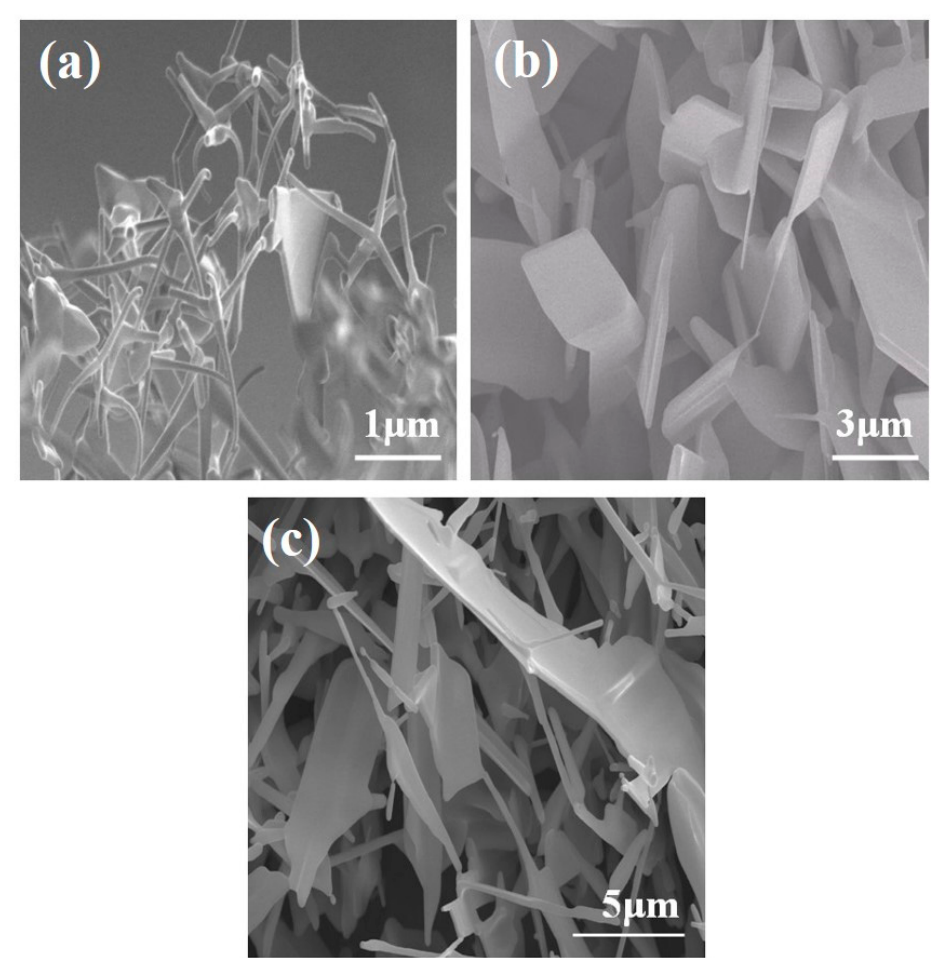
Figure 2. Field-emission scanning-electron-microscope (FE-SEM) images of ZnO nanostructures grown on Au-coated Si substrates at a constant growth temperature of 800 °C in parallel setup with varying Ar/O 2 flow rates in the gas mixture; ( a ) 120/0.1 sccm, ( b ) 120/1.0 sccm, and ( c ) 120/2.5 sccm.